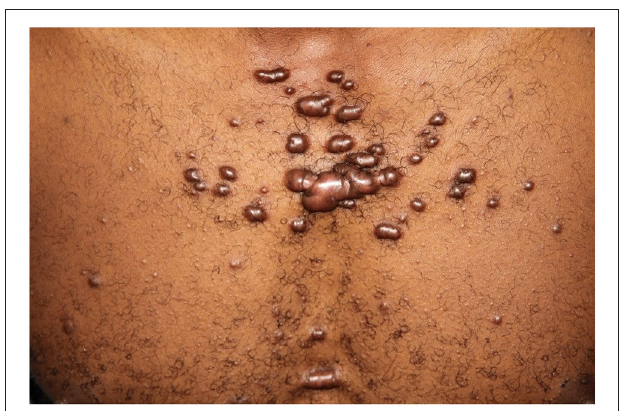
FIGURE 1 | Ritual behavior like cutting the skin in many African and Asian countries contribute to chronic itch caused by keloid manifestation in variable shape and